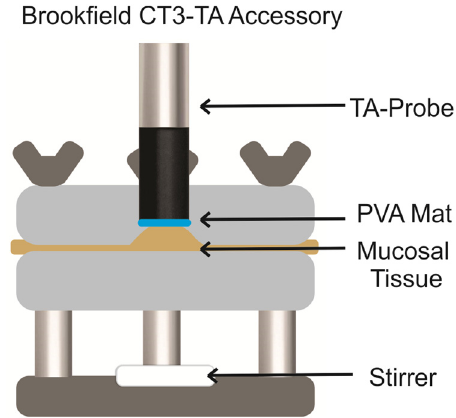
Figure 1: Schematic representation of the adhesive